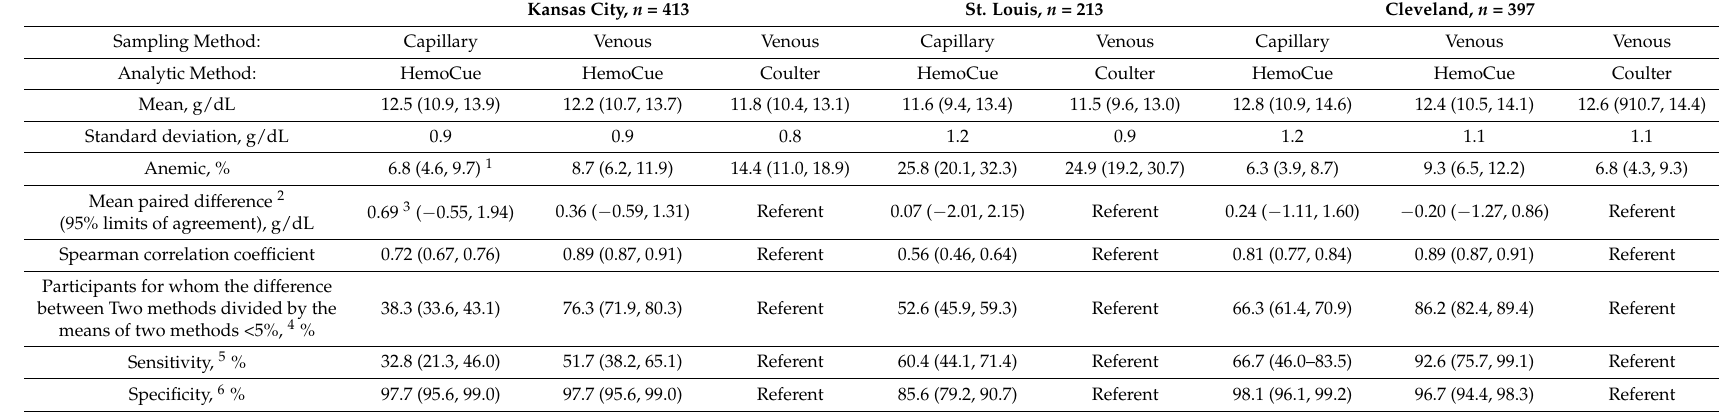
Table 2. Comparisons of hemoglobin concentration measurements among Women, Infants, and Children (WIC) participants in three previous studies, by sampling and analytic method for data collected between 2002 and